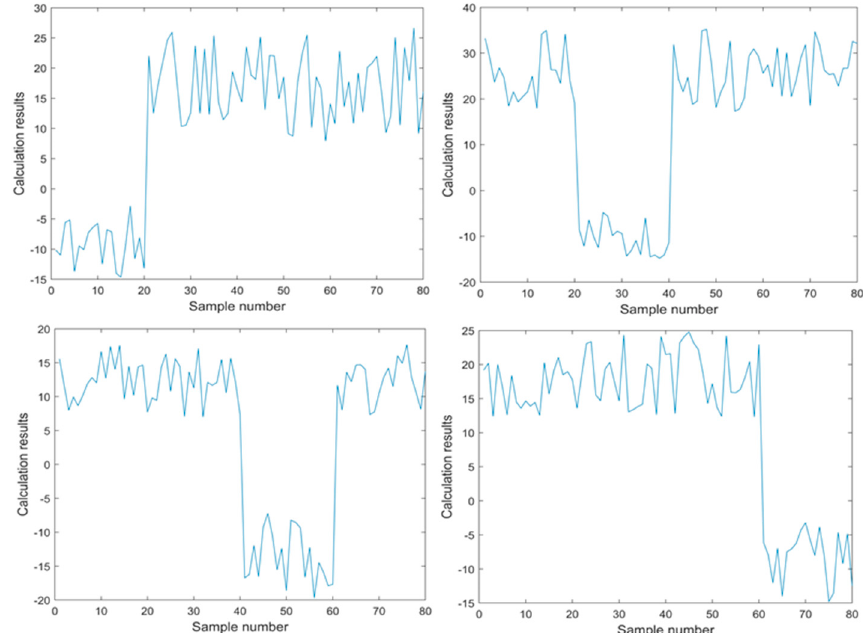
Figure 11. Calculation results of four types of samples under improved hyperplane.